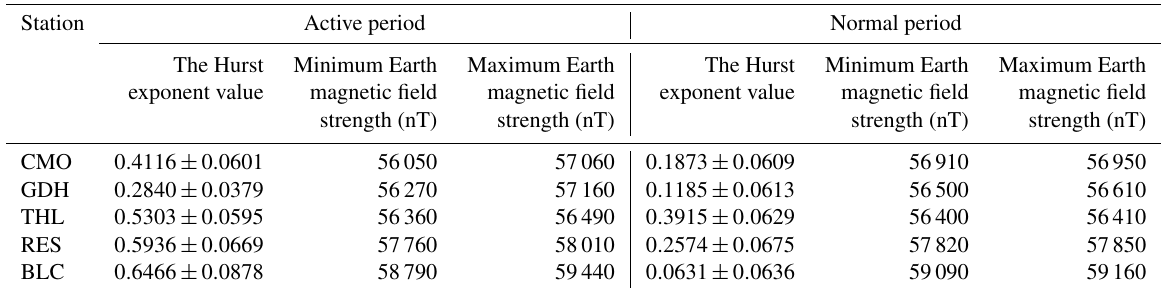
Figure 7 represent the periodogram for the midlatitude re- gion during the active period and normal period. The midlat- itude region is situated from 30 to 60 ◦